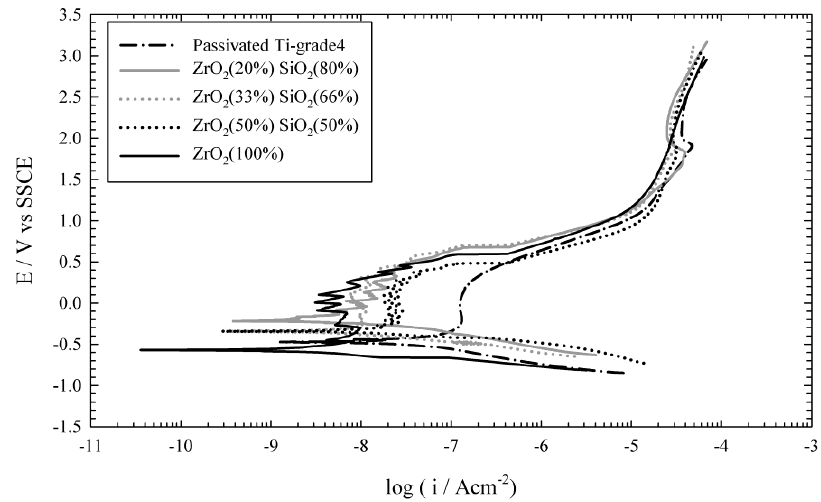
Figure 7. Potentiodynamic polarizations performed in a DPBS + BSA electrolyte on the bare passivated Ti-4 disk and on disks coated with 20 wt.% SiO 2 /ZrO 2 , 33 wt.% SiO 2 /ZrO 2 , 50 wt.% SiO 2 /ZrO 2 and pure ZrO 2